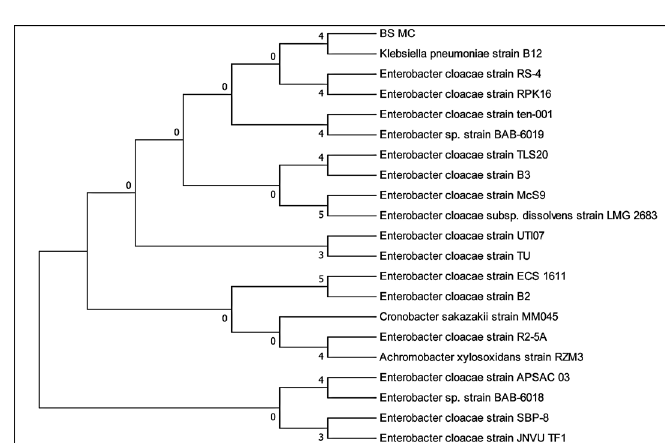
Fig. 4. Phylogenetic tree of